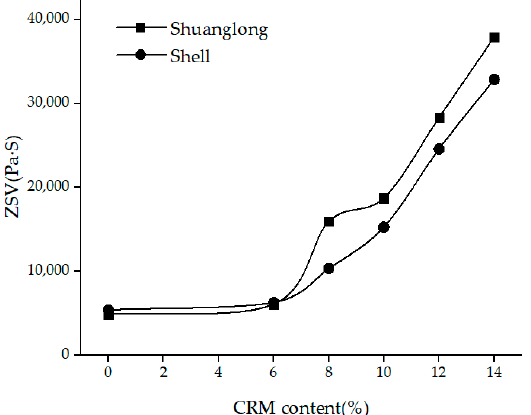
Figure 7. ZSV of hybrid modified asphalt binders with different CRM content.